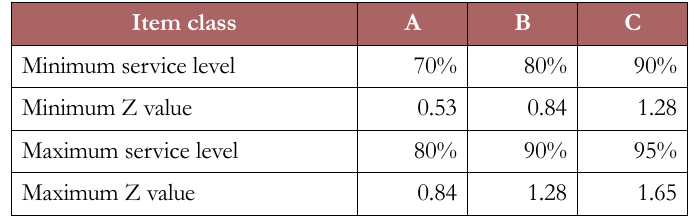
Table 2. Service level (Martins & Laugeni,